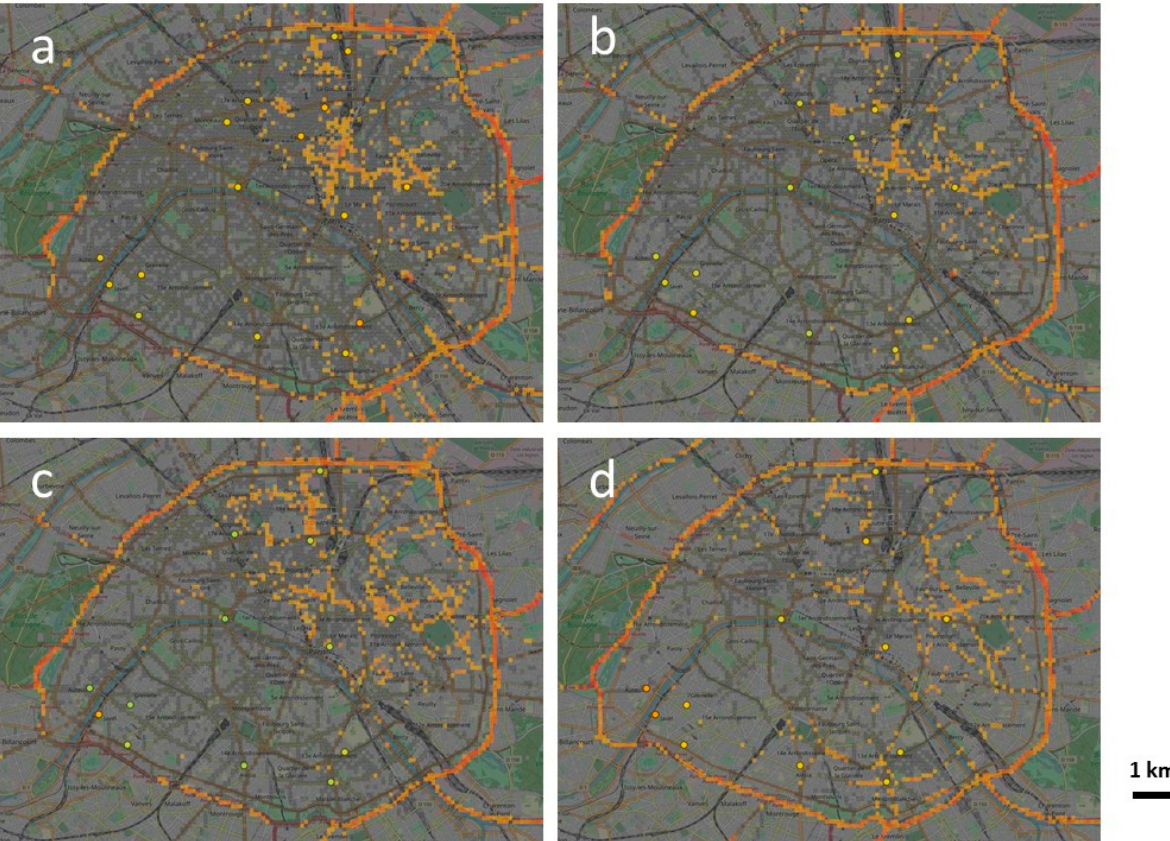
Figure 19. Hot spots » for January 2020 ( a ), March 2020 ( b ), September ( c ) and November 2020 ( d ). Linear scale where yellow color represents 50% of measurements above the mean and red color represents 100% of measurements above the mean. North is up.